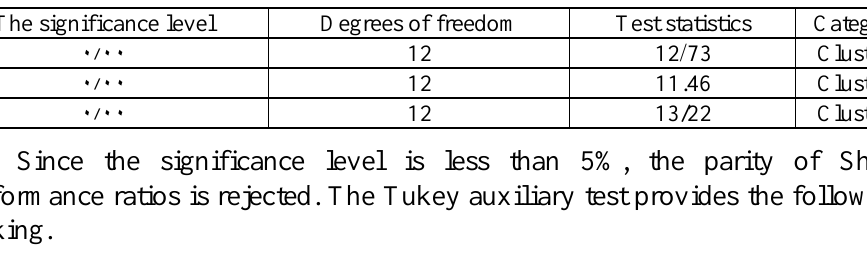
Table 5. Results of analysis of variance (research findings)